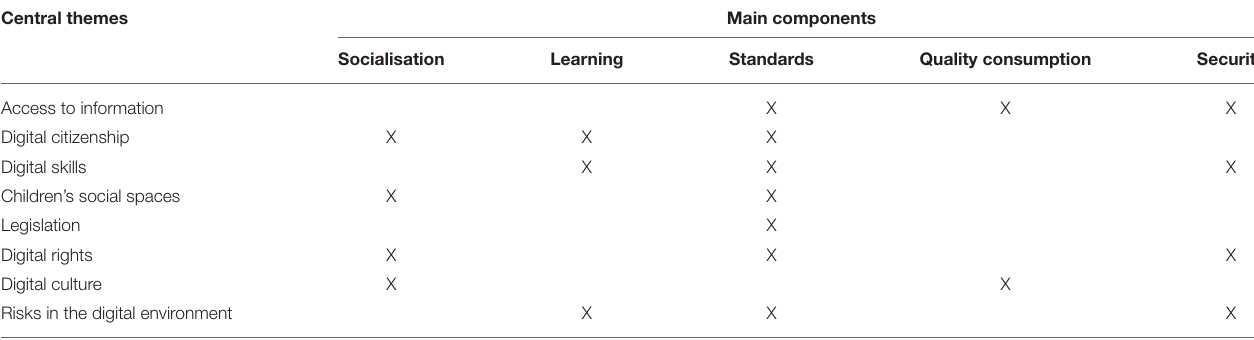
TABLE 6 | Relationships established between core themes and principal components based on grounded theory analysis. Central